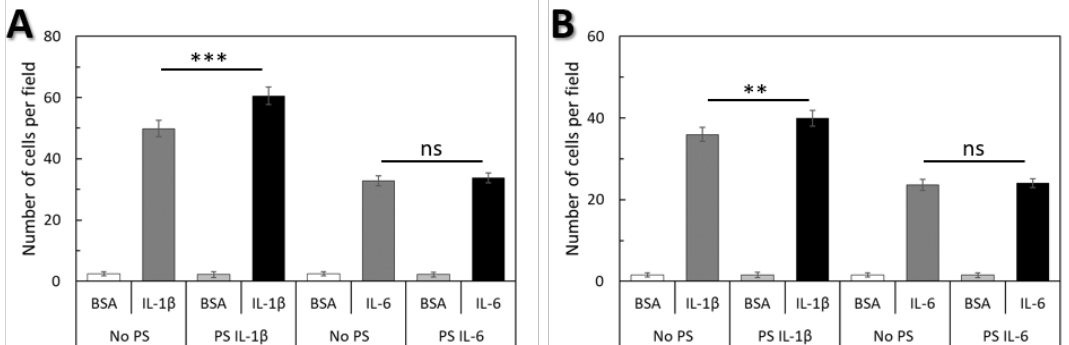
Figure 7. IL-1 β and IL-6 induced WJ-MSCs transendothelial migration ( A ) and invasion ( B ). Pre-stimulation with IL-1 β (PS IL 1 β ) increased transendothelial migration and invasion of WJ-MSCs toward IL-1 β in vitro, but pre-stimulation with IL-6 (PS IL-6) did not a ff ect the size of transendothelial migration and invasion toward IL-6. Data shown are the mean ± standard deviation of duplicate experiments, an average of 6 donors. An ANOVA with post-hoc Tukey test was applied to statistically verify the obtained results (ns: no significant difference).